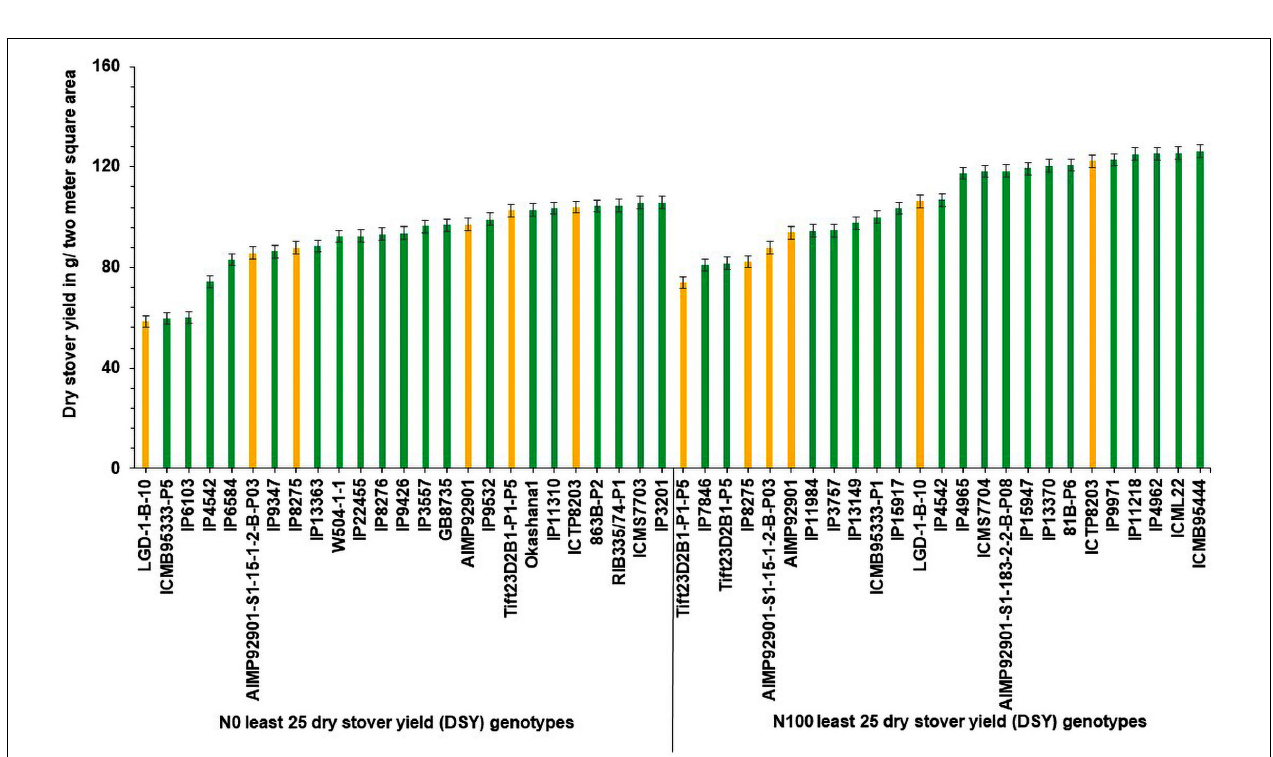
FIGURE 4 | Least performing genotypes for dry stover yield (DSY) under N 0 and N 100 conditions.